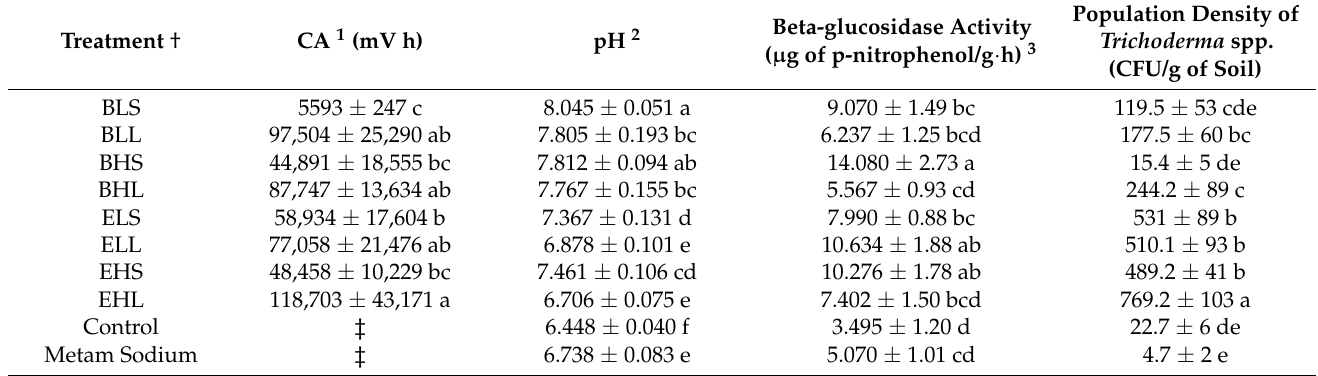
Table 4. Effect of treatments on the physicochemical and biological characteristics of the